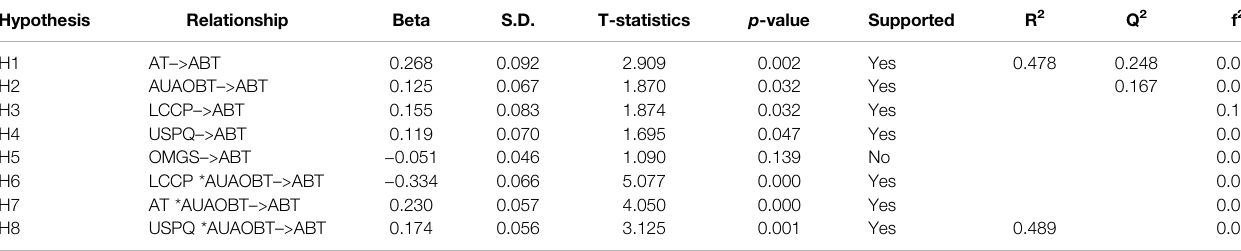
TABLE 6 | Structural model results (hypothesis testing). Hypothesis